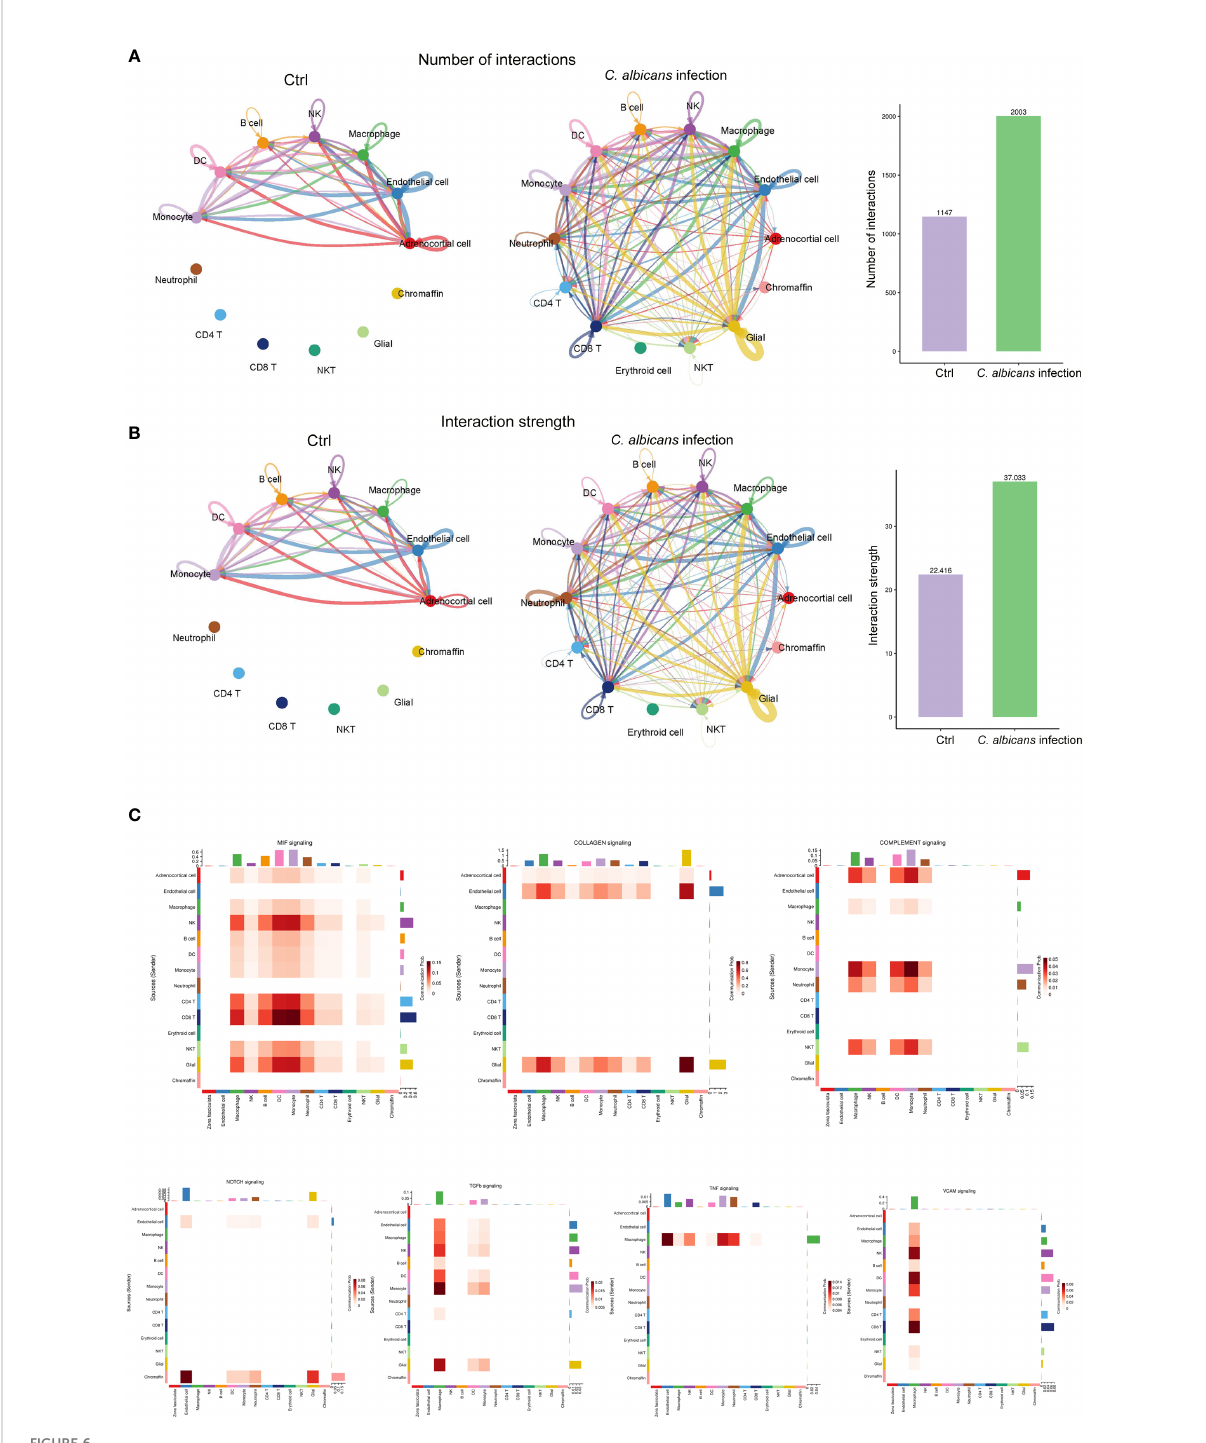
FIGURE 6 Cell-cell communication network analysis of multiple cellular connections in murine adrenal glands after systemic C. albicans infection. (A) The numbers and (B) the strength of the cellular interactions network in C. albicans infection and control groups. The nodes represent different cell types. The connecting line indicates the interaction between cell types, which color is the same as that of the ligand cell, and the arrow points to the receptor cells. The thickness of the line indicates the degree the number or strength of interactions. (C) Heatmaps showing the communication relationships at representative signaling pathways, with the X-axis and Y-axis representing the receptor cell and the ligand cell types, respectively. The top and right colored bars represent the sum of received and sent signals in each cell type,